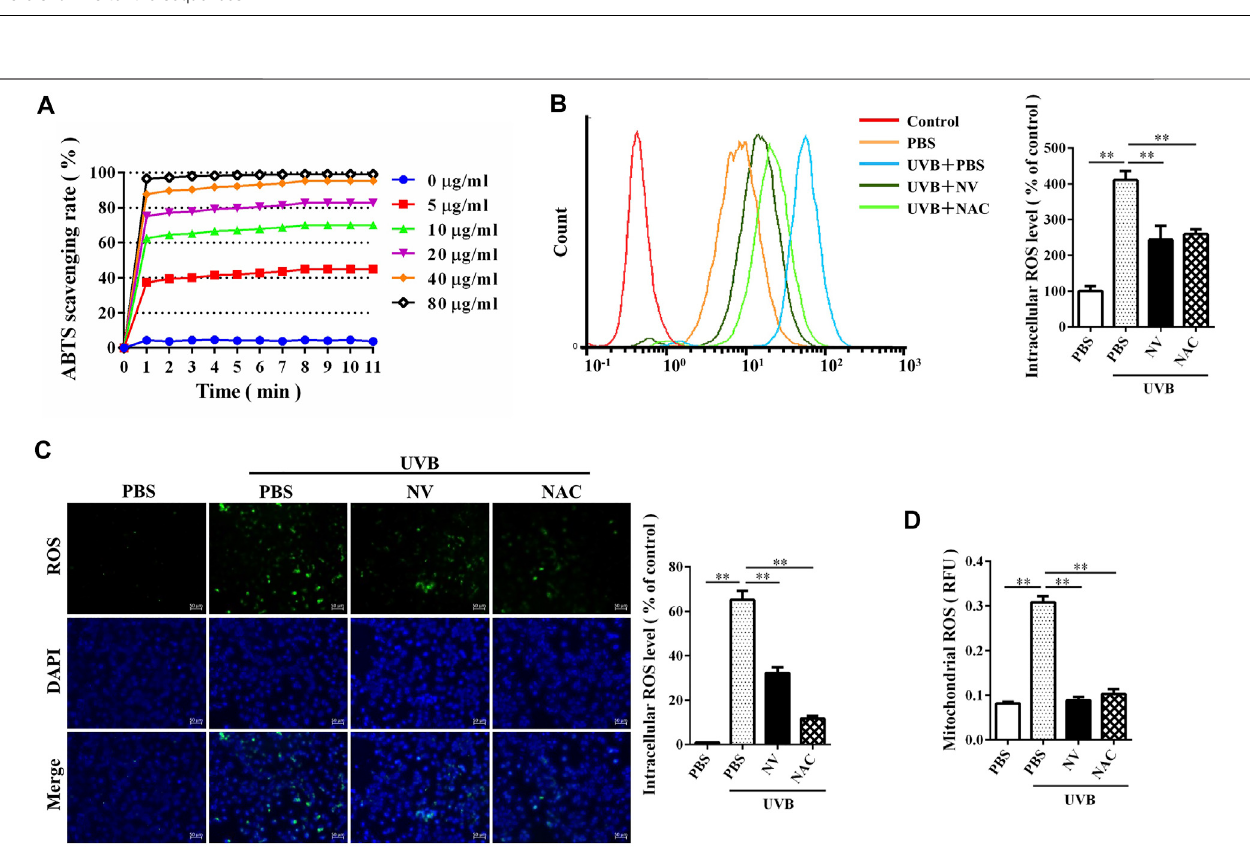
FIGURE 2 | Antioxidin-NV rapidly scavenged UVB-induced intracellular and mitochondrial ROS for HaCaT cells, and eliminated arti fi cial free radicals ABTS + . (A) Percent rate of ABTS + was scavenged by antioxidin-NV in a dose and time dependant manner. Antioxidin-NV showed strong antioxidant activities. (B) Antioxidin-NV suppressed intracellular ROS generation. ROS generation levels were determined by treating the samples for 24 h after UVB irradiation. DCFH-DA (10 μ M) was introduced into HaCaT cells, and fl uorescence was measured by fl ow cytometry. (C) DCFH-DA fl uorescence in HaCaT cells was measured by confocal microscopy. Intracellular ROS is stained green. Scale bar (cid:1) 100 μ m. (D) Antioxidin-NV suppressed mitochondria ROS generation for HaCaT cells. NAC (ROS inhibitor) was used as a positive control; Data are presented as mean ± SD ( n (cid:1) 3). ns, no signi fi cance, ** p < 0.01, *** p < 0.001.